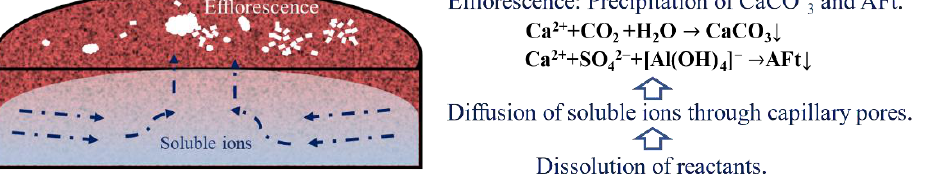
Figure 8. Schematic process diagram for the formation of efflorescence in ettringite-rich system. In terms of the effect of mineral additives on efflorescence, ref. [16] put forward that